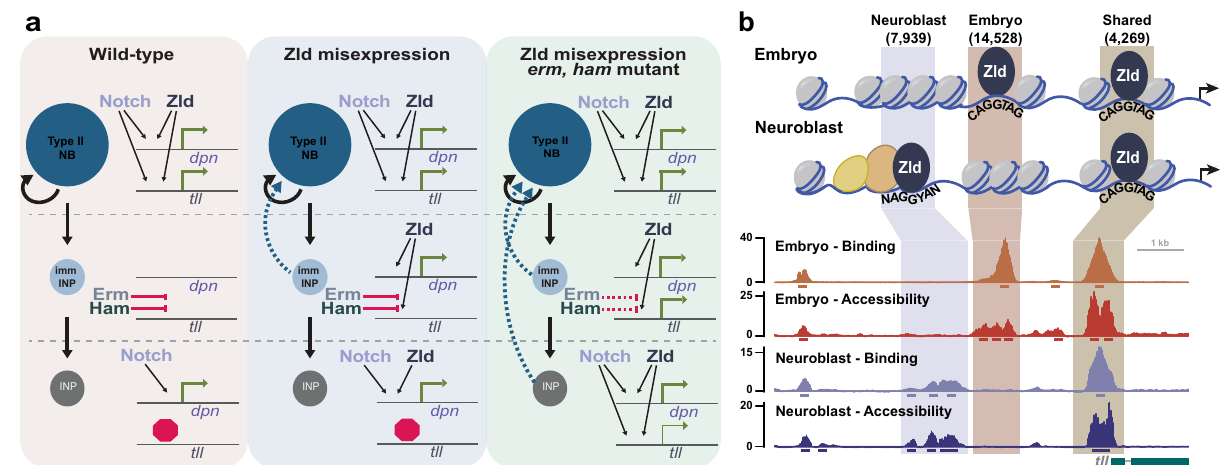
Fig. 7 Zld promotes the undifferentiated state through neuroblast-speci fi c enhancers that become progressively silenced during differentiation. a Zld functions in parallel to Notch to maintain type II neuroblasts in an undifferentiated state through activation of tll and dpn . Downregulation of Notch signaling in newly born INPs allows Erm and Ham to become sequentially activated during INP commitment. In the INPs, Erm- and Ham-mediated silencing of tll prevents reactivation of Notch signaling from inducing tll expression and driving reversion to neuroblasts. When misexpressed in immature INPs, Zld activates dpn expression and promotes reversion to a neuroblast. The red octagon/stop signs indicate the changes to the chromatin structure mediated by Erm and Ham that limit the ability of Zld to drive tll expression and therefore reprogram mature INPs. b Cell-type-speci fi c binding by Zld correlates with chromatin accessibility and identi fi es tissue-speci fi c enhancers. Type II neuroblast-speci fi c Zld-binding sites are not enriched for the canonical Zld-binding motif and are instead enriched for sequences corresponding to additional co-factors that may stabilize Zld binding or promote chromatin accessibility at these